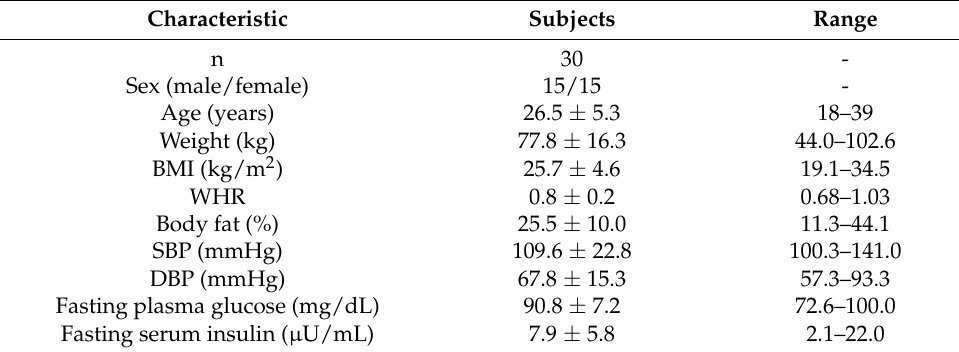
Table 1. Characteristics of subjects who participated in the study. Characteristic Subjects